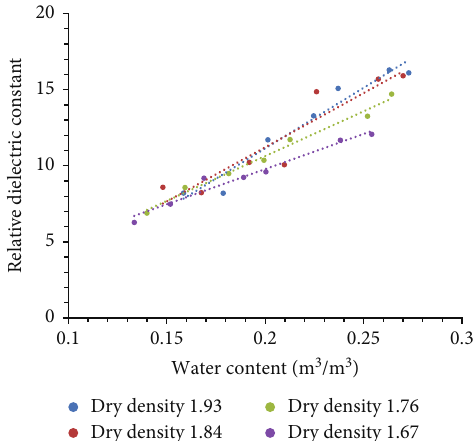
Figure 12: The dielectric permittivity values relationship of samples changing with the same compaction level and di ff erent water contents under di ff erent frequency